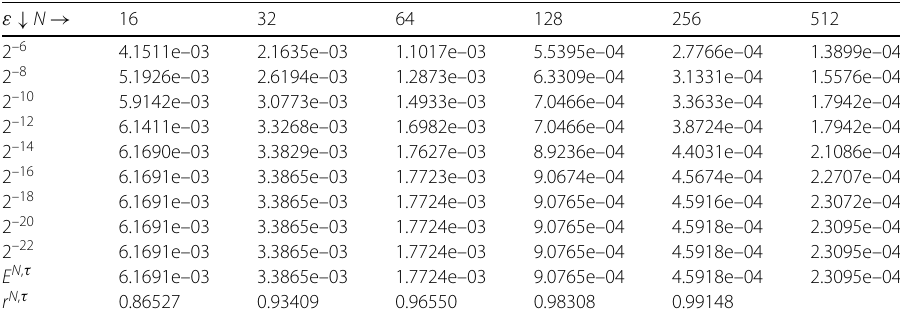
Fig. 1. The effects of ε and the time step on the solution profile for the considered problems Table 1 E N , τ ε , E N , τ , and r N , τ for Example 5.1 with M =